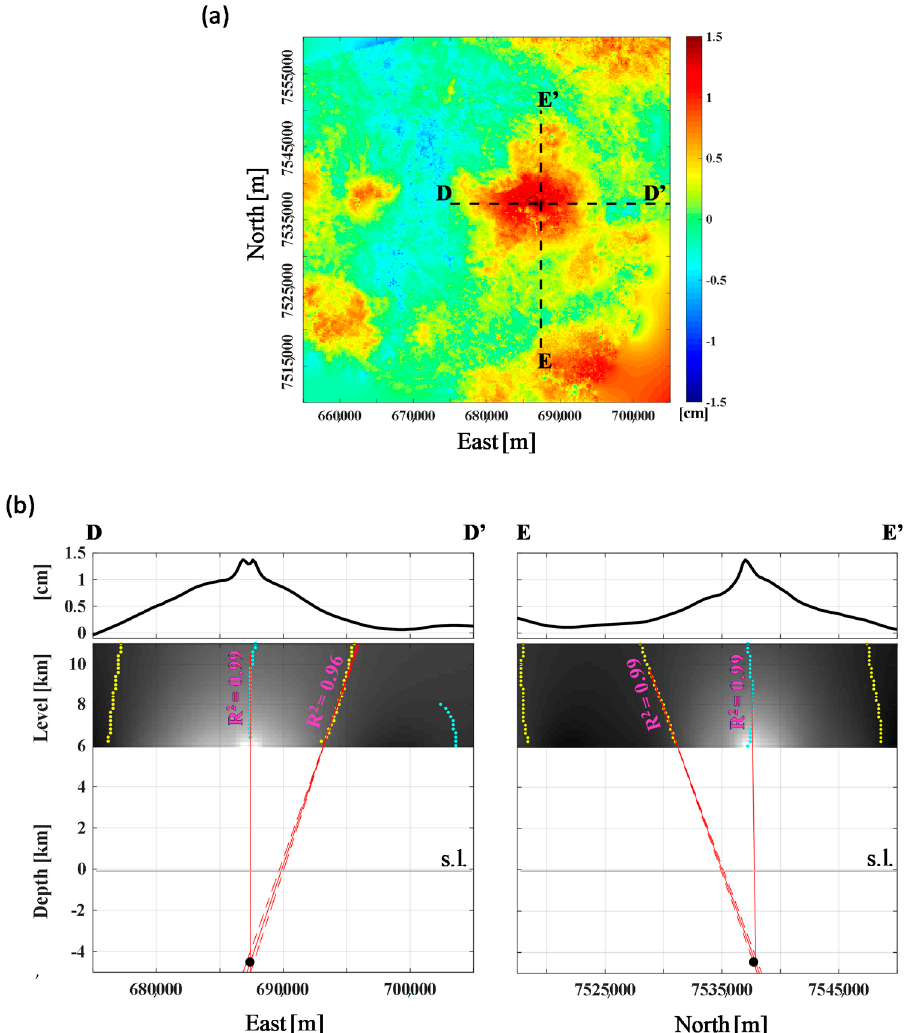
Figure 5. Multiridge analysis of August 2006–February 2007 time interval. ( a ) Gridded vertical deformation (cm); the black dashed lines represent the DD’ and EE’ traces; ( b ) Detection of deformation sources by using Multiridge method applied to the DD’ (left) and EE’ (right) profiles of the vertical deformation map (in ( a )); the red solid and dashed lines represent the best-fit regression lines and the linear regression boundary solutions within a 95% confidence interval, respectively; the black solid circles indicate the ridges intersections; for each regression line, we indicate the R 2